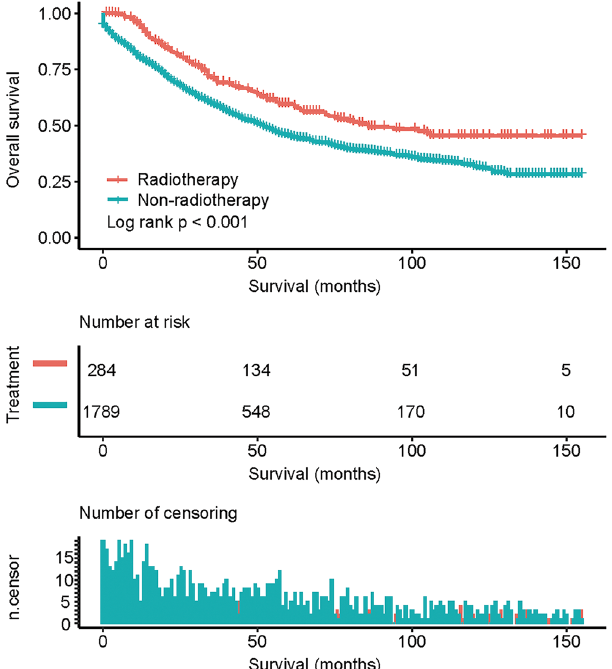
Figure 2. Overall survival (OS) rates for all patients (radiotherapy vs. non-radiotherapy, P < 0.001). Pictures show the number of subjects at risk in each group at 50-month increments. Pictures show the number of censoring in each group at 50-month